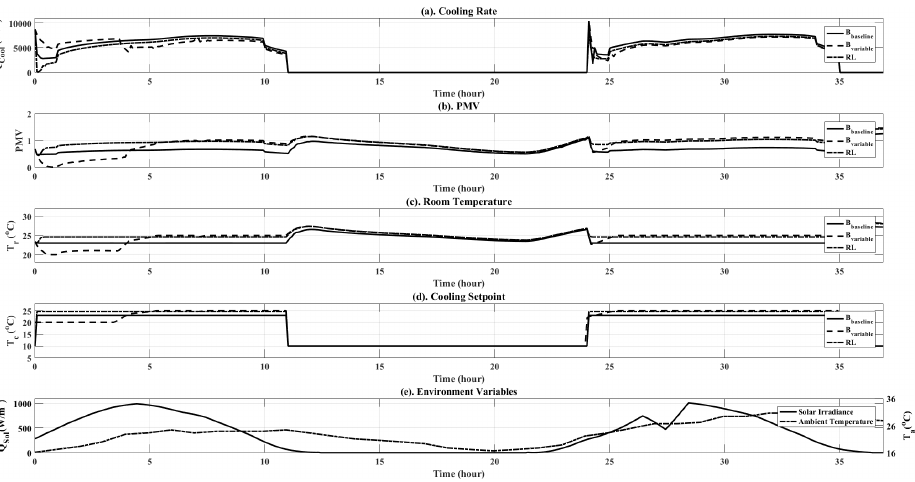
Figure 10. Simulation results plots for comparison between B ideal , B variable and the RL controller over two days. Plots are shown for both objective variables ( Q cool and PMV), as well as additional simulation data, such as ambient temperature and solar irradiance.